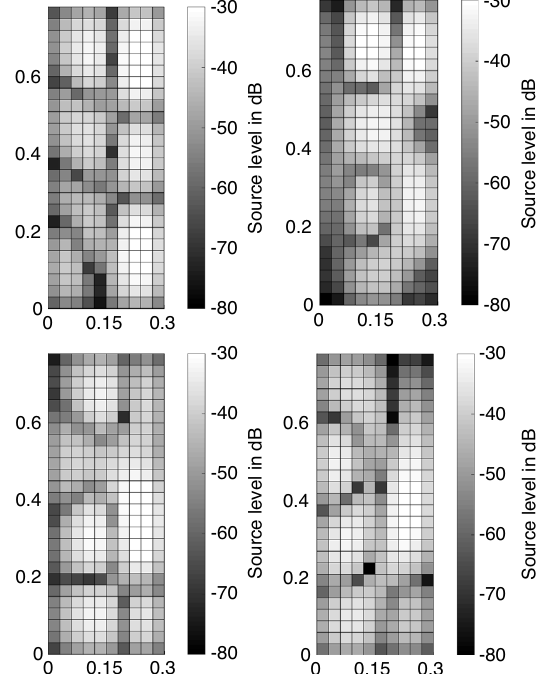
Figure 23. Results of the reconstructed vibration pattern at 100 Hz (left upper corner), 250 Hz (right upper corner), 500 Hz (left lower corner) and 1000 Hz (right lower